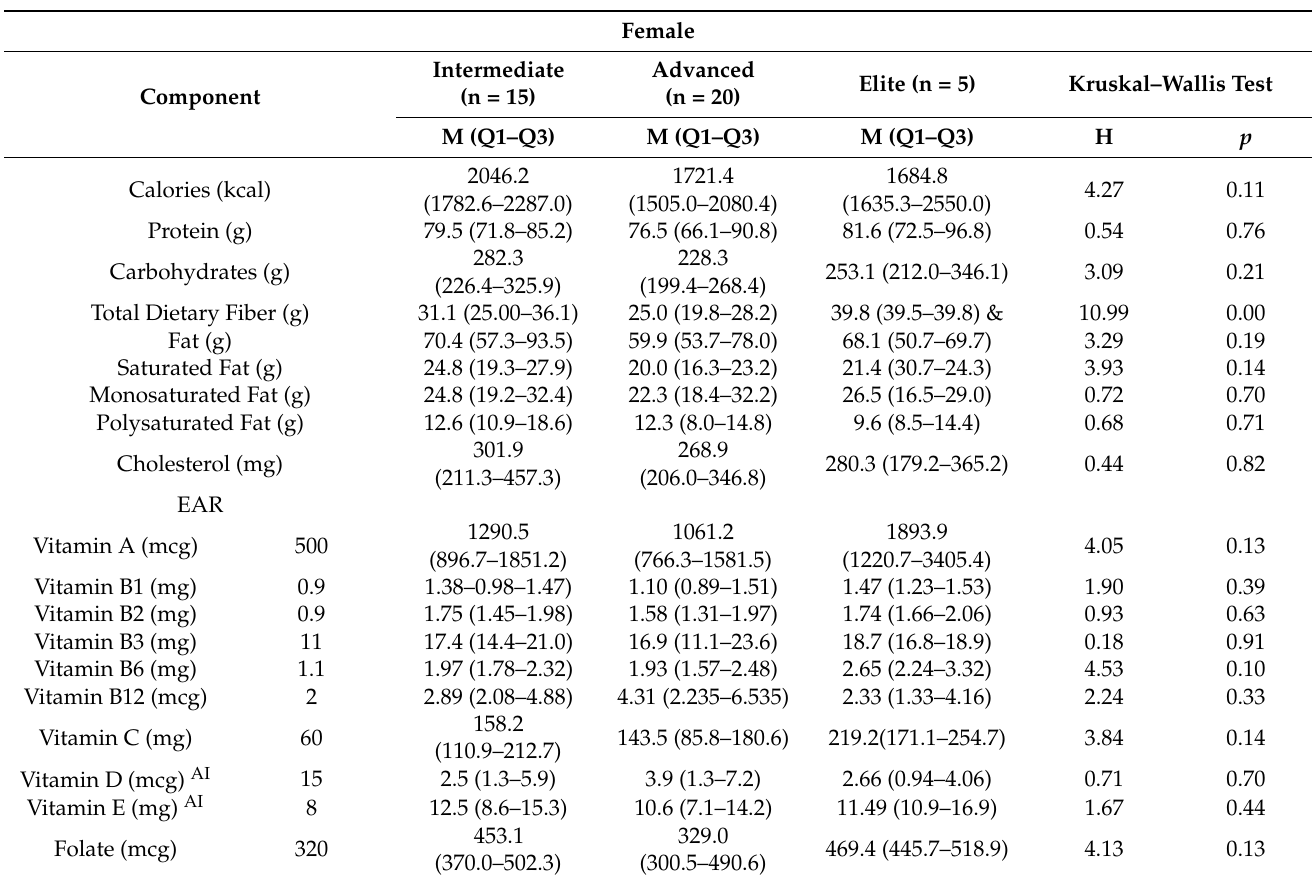
Table 4. Comparison of the macronutrient and micronutrient intakes of female and male sports climbers of different climbing